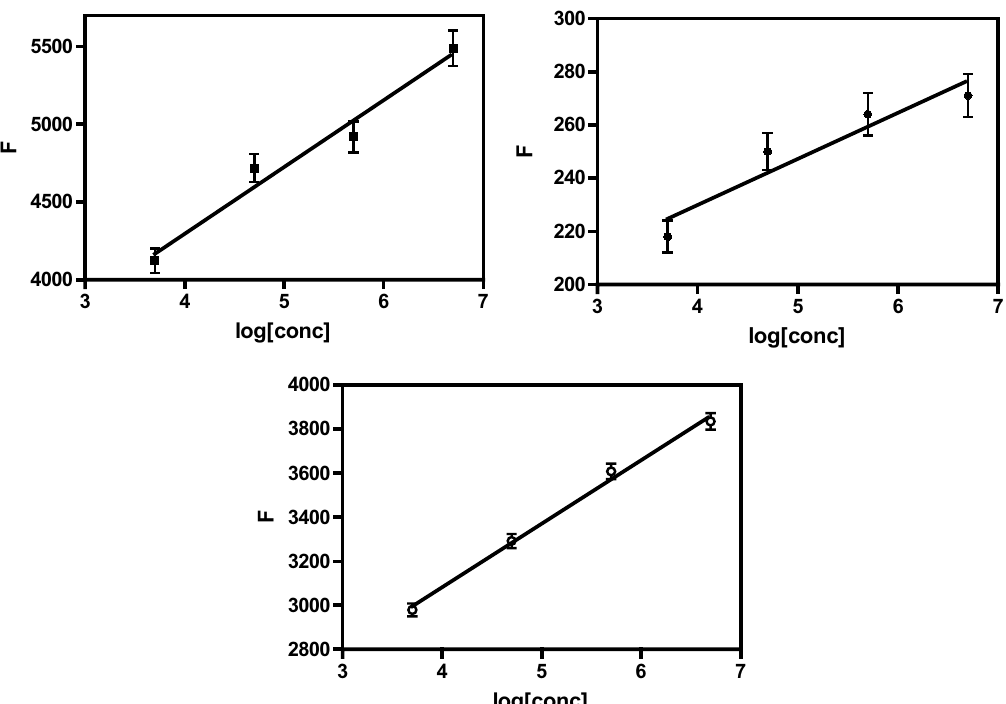
Fig. 3. Calibration curves using Pseudomonas sp. cells isolated from the outgrowth of the sample from Palander Site 1. F is the measured °uorescence in relative units and the surface concentration is in cells/cm 2 . For the 635 nm excitation/770 nm emission pair [top left], F ¼ 429 : 7 log[conc] þ 2577.1 with R 2 ¼ 0 : 97. For the 590 nm excitation/675 nm emission pair [top right], F ¼ 17 : 2 log [conc] þ 162.0 with R 2 ¼ 0 : 89. For 365 nm excitation/440 nm emission pair [bottom], F ¼ 288 : 4 log[conc] þ 1929.4 with R 2 ¼ 0 : 995. R 2 is the square of the Pearson product moment correlation coe±cient.